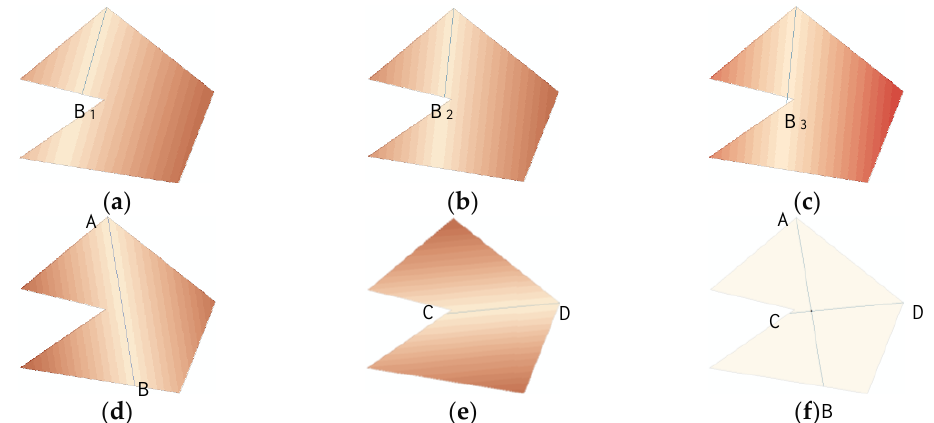
Figure 3. Centroid computing of polygon Q : ( a ) result of the Euclidean distance transformation of Line AB 1 ; ( b ) result of the Euclidean distance transformation of Line AB 2 ; ( c ) result of the Euclidean distance transformation of Line AB 3 ; ( d ) first final centroid balance line AB ; ( e ) second final centroid balance line CD ; ( f ) result of final centroid of the polygon Q .